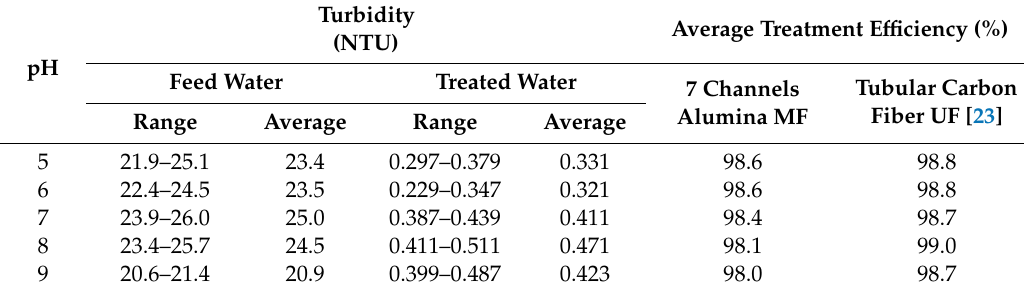
Table 9. Water quality and treatment e ffi ciency of turbidity in the hybrid process of 7-channel alumina MF (HC10) and PP beads for the e ff ect of pH as compared with results of tubular carbon fiber UF (C005) membrane.